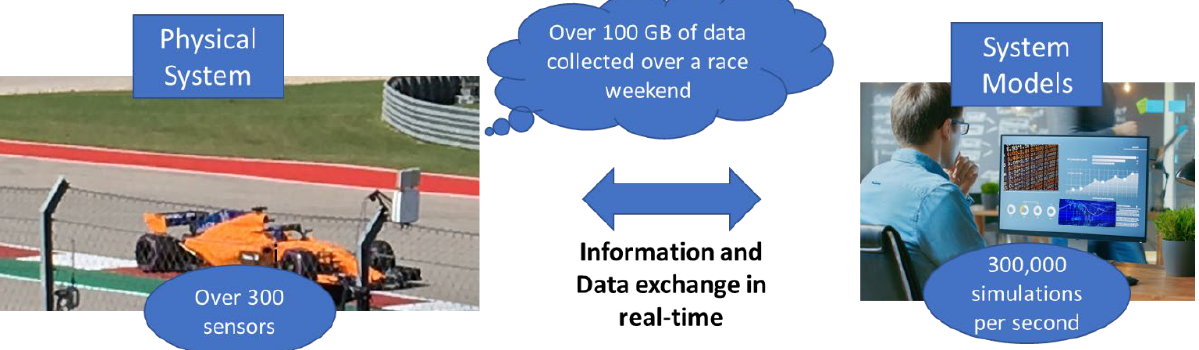
Figure 1. The three components of digital twinning demonstrated through application in auto racing strategy planning, based on information from [4].